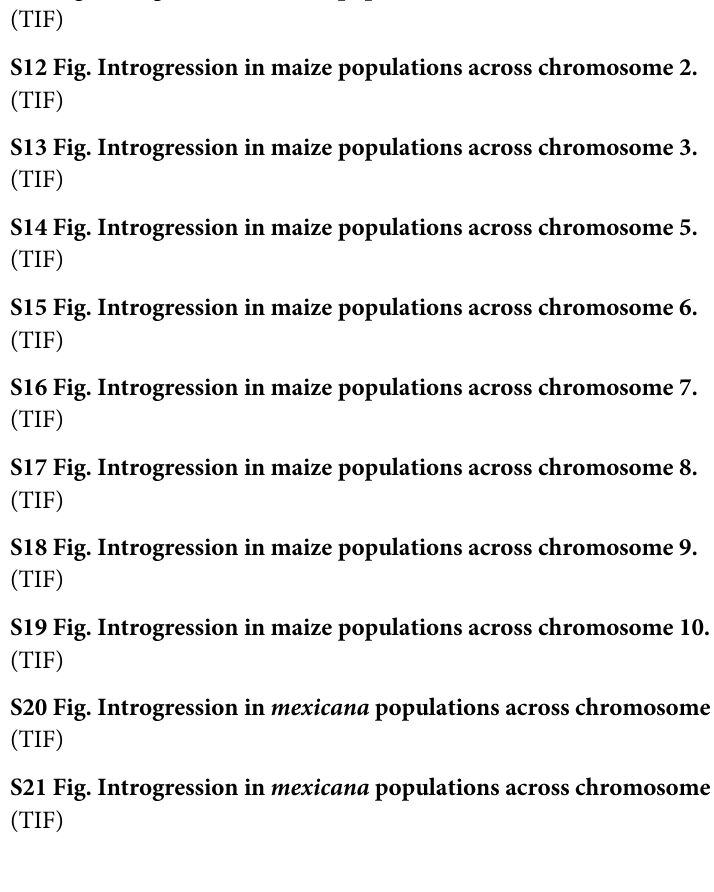
S12 Fig. Introgression in maize populations across chromosome 2. S13 Fig. Introgression in maize populations across chromosome 3. S14 Fig. Introgression in maize populations across chromosome 5. S15 Fig. Introgression in maize populations across chromosome 6. S16 Fig. Introgression in maize populations across chromosome 7. S17 Fig. Introgression in maize populations across chromosome 8. S18 Fig. Introgression in maize populations across chromosome 9. S19 Fig. Introgression in maize populations across chromosome 10. S20 Fig. Introgression in mexicana populations across chromosome 1. S21 Fig. Introgression in mexicana populations across chromosome